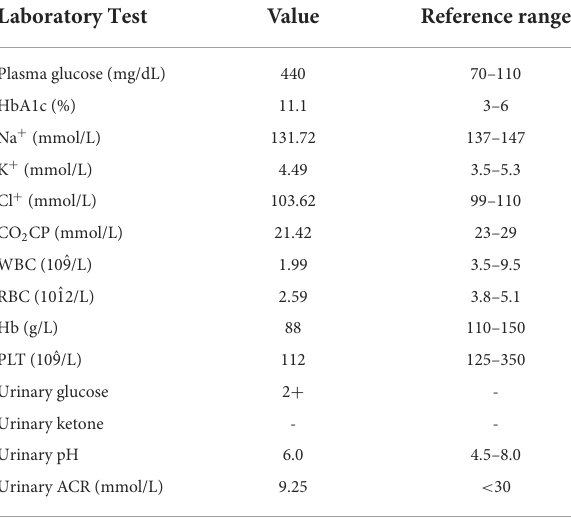
TABLE 1 Laboratory parameters at the time of hospital admission.